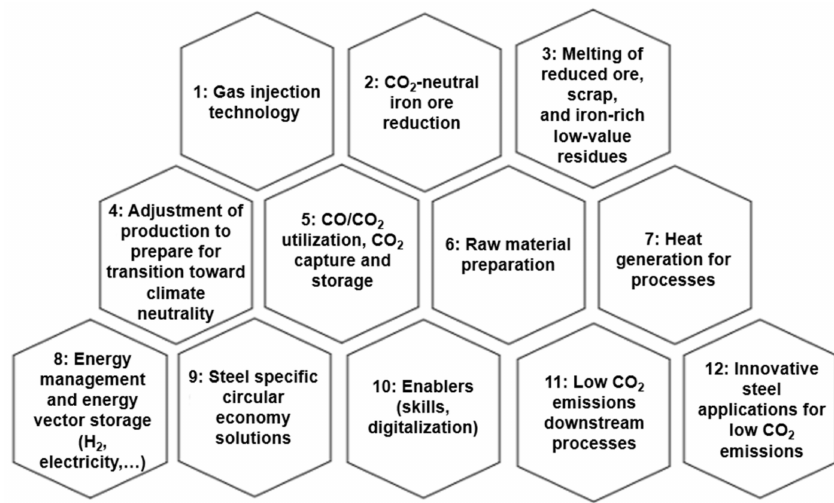
Figure 18. The twelve building blocks of the Clean Steel Partnership